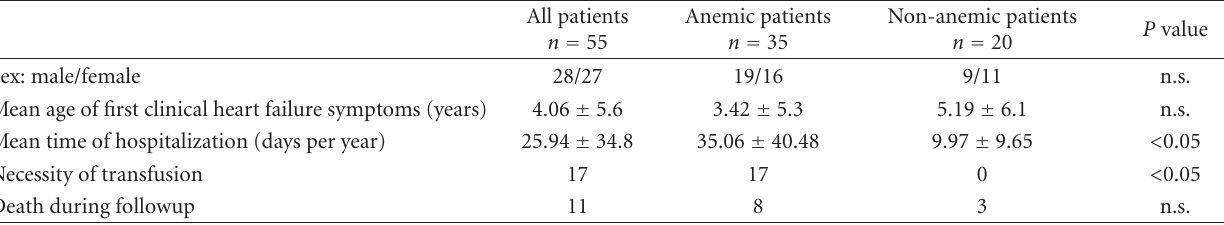
Table 1: Demographic and clinical characteristics of children with congestive heart failure due to DCM. (Values correspond to number ( n ) of patients or to means ± SD.)